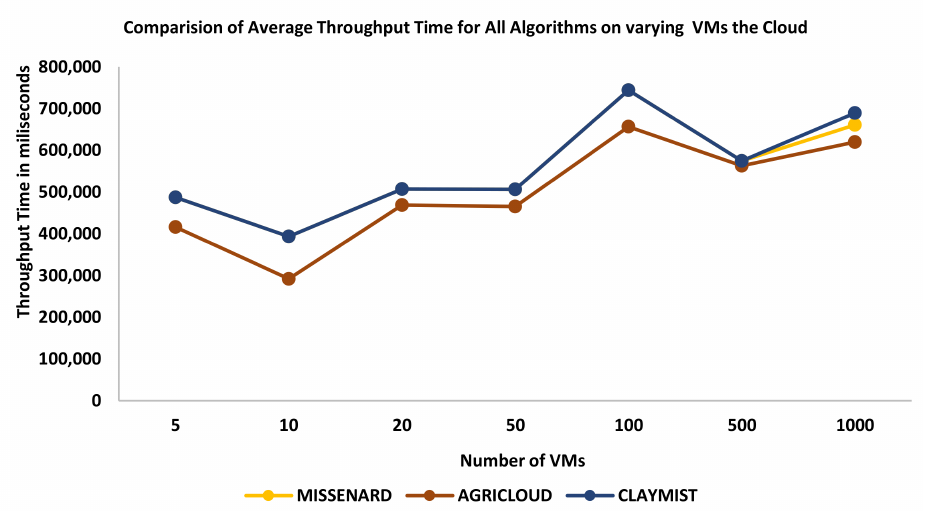
Figure 3. Throughput time of AGRICLOUD with baselines.